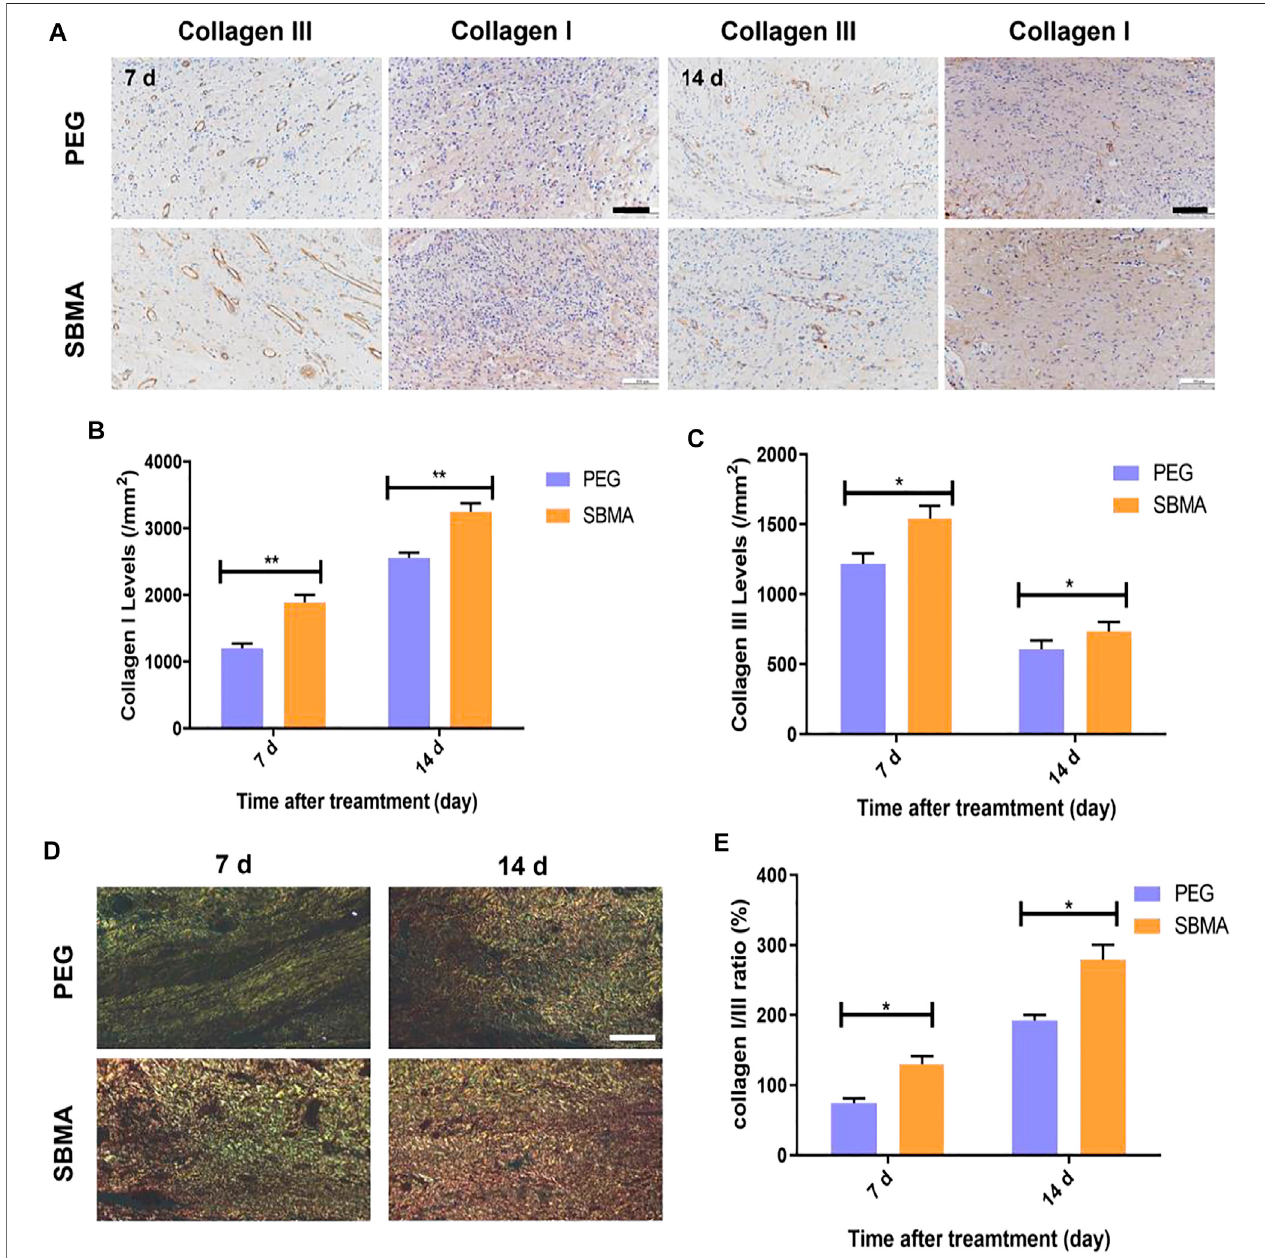
FIGURE 4 | PEG and SBMA hydrogels promote the formation of collagen deposition. (A) Immunohistochemical staining results of collagen III (scale bar (cid:1) 50 µm) and collagen I(scale bar (cid:1) 100 µm) for wounds treated by PEG or SBMA hydrogels for 7 and 14 days. (B) Quantitative analysis ofcollagen Ilevels at days 7 and 14 after treating with PEG and SBMA hydrogels. (C) Quantitative analysis of collagen III levels at day 7 and 14 after treating with PEG and SBMA hydrogels. (D) Representative images of picrosirius red (PSR) staining of collagen fi bers at the wound areas on days 7 and day 14 (scale bar (cid:1) 100 µm). (E) Quantitative analysis of collagen I/III ratio at day 7s and 14. Signi fi cant difference is indicated as * p < 0.05, ** p < 0.01, n (cid:1) 3.